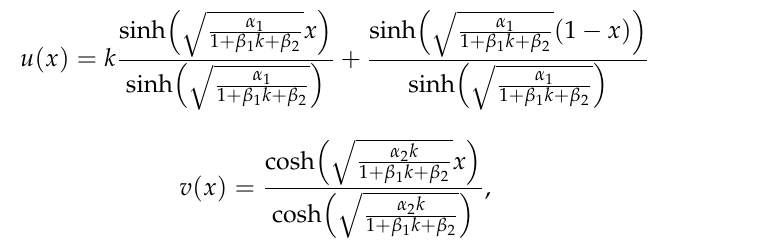
( b ) Effect of variations in k on con- centration of PGE.